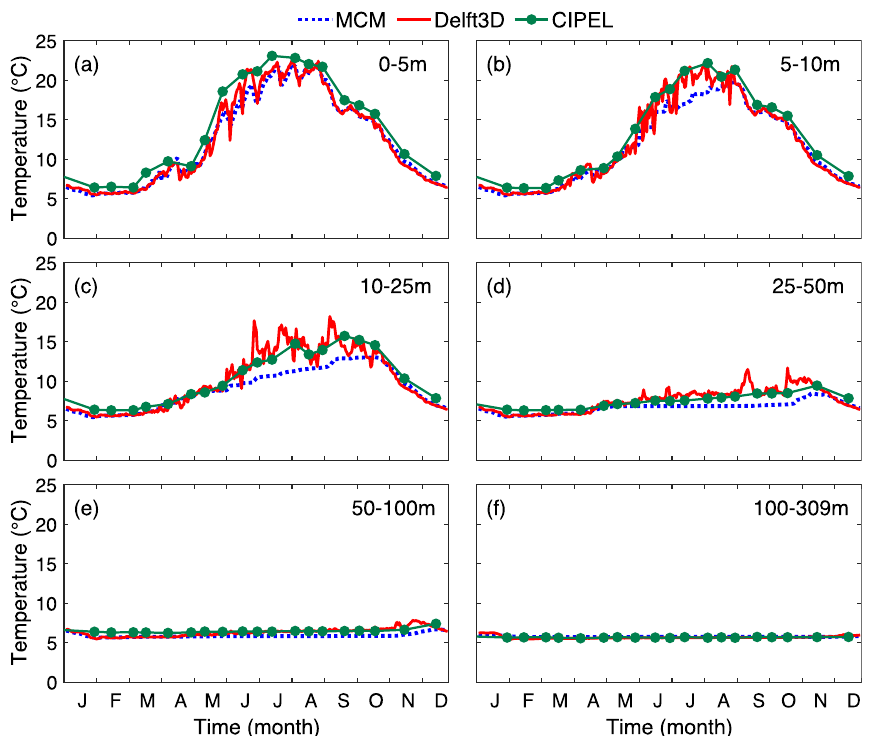
Figure 5. Evolution of the temperature simulated by the MCM and Delft3D at 1100UTC at station SHL2 at ( a ) the surface (0–5 m), ( b ) 5–10 m, ( c ) 10–25 m, ( d ) 25–50 m, ( e ) 50–100 m, ( f ) 100-309 m. Plots generated with Matlab 25 ; Panels assembled with Adobe Illustrator 26